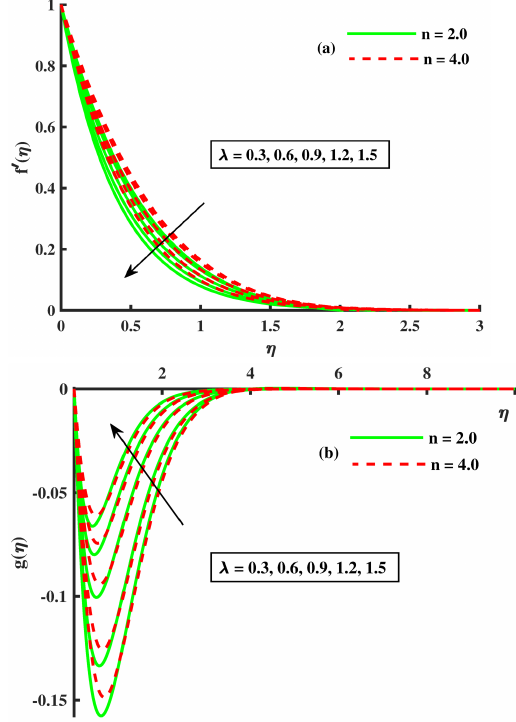
Figure 3. The effect of λ & n on f (cid:48) ( η ) & g ( η